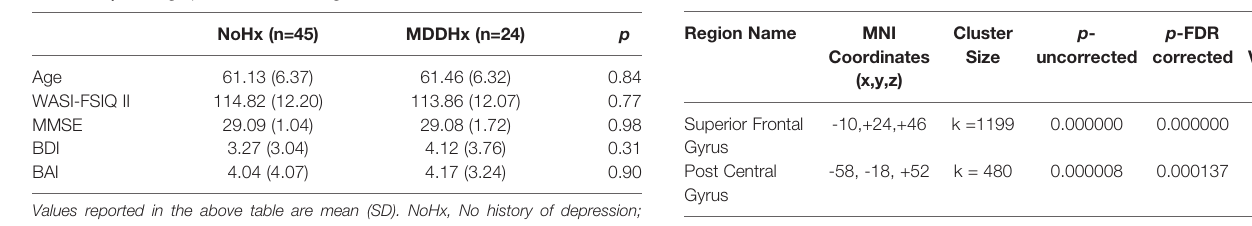
TABLE 3 | Signi fi cant